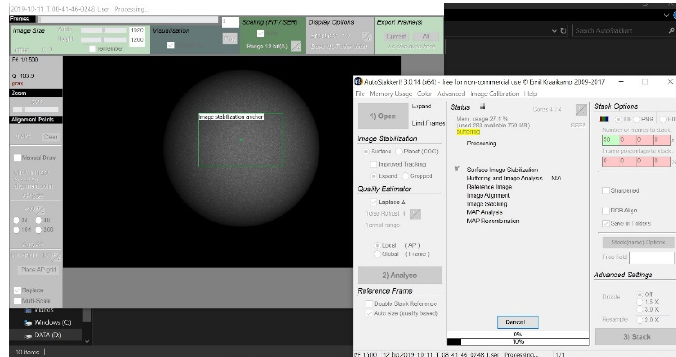
Figure 9. AutoStakkert3! analyzing a video